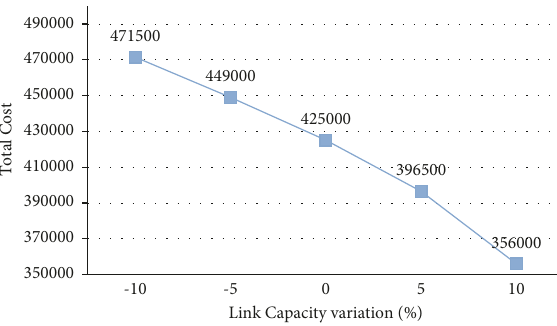
Figure 11: Effect link capacity on the total cost.